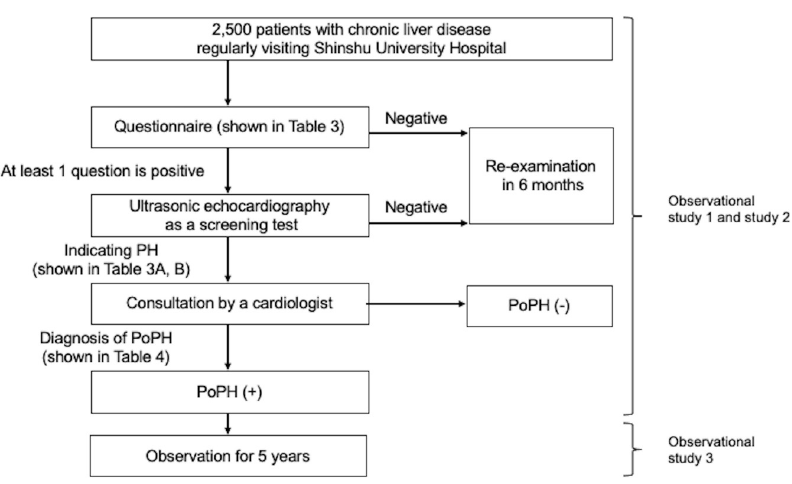
Fig 1. The study flowchart. Abbreviations: PH, pulmonary hypertension; PoPH, portopulmonary hypertension.